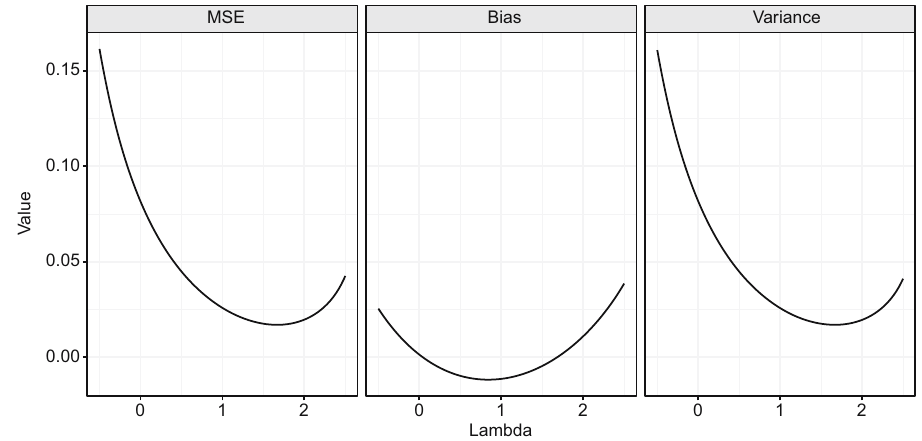
as a function of λ in an instance of the normal model described in ( 18 ) with n 250 = , λ